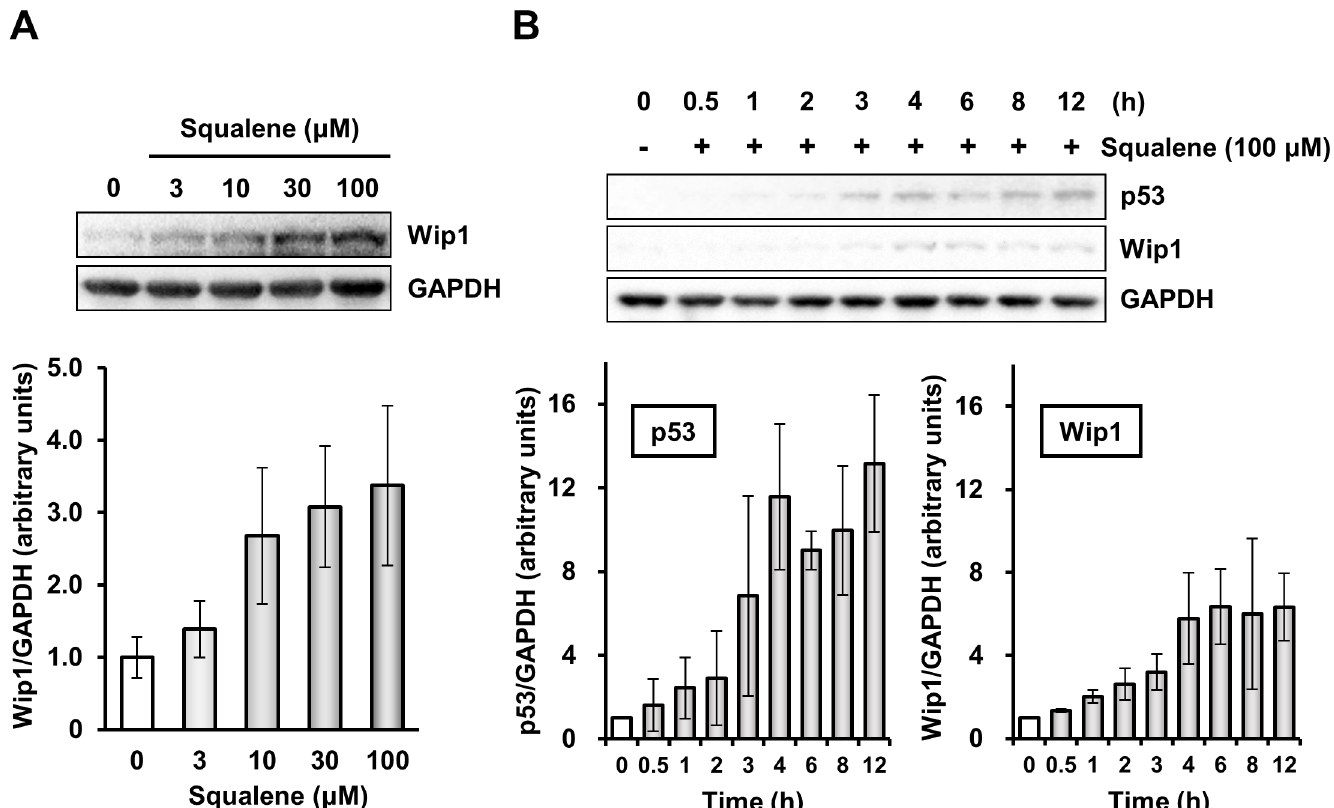
Fig 6. Squalene increases Wip1 expression in a concentration- and time-dependent manner. (A) A549 adenocarcinoma cells were incubated with squalene (0, 3, 10, 30, and 100 μ M) for 4 h. (B) A549 adenocarcinoma cells were incubated with squalene (100 μ M) for 0 to 12 h. Expression of p53 and Wip1 expression was examined by immunoblot analysis. GAPDH was used as a loading control. Densitometric analysis of the bands was performed using Image Quant 5.2